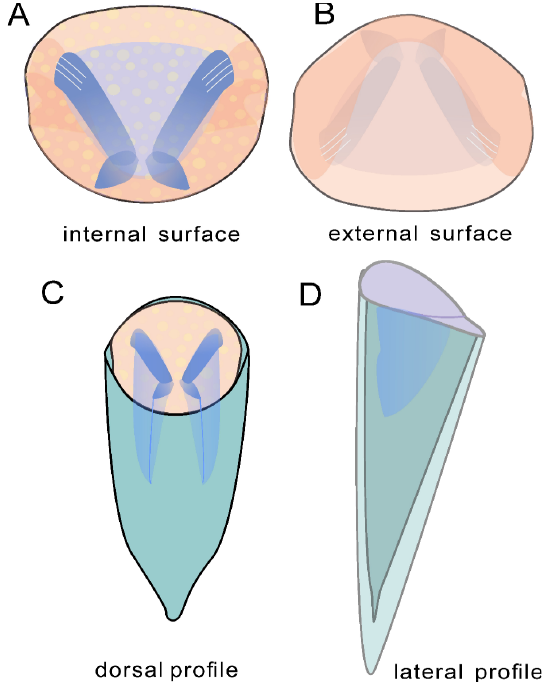
Figure 7. Simplified reconstruction of Doliutheca orientalis from the Shipai Formation of the Xiacha- zhuang section, Hubei Province, China. ( A , B ) Sketch of operculum. ( C ) The steinkern with articu- lated operculum, noting the platy clavicles. ( D ) Sketch of reconstruction showing Doliutheca orien- talis with shell in lateral profile.